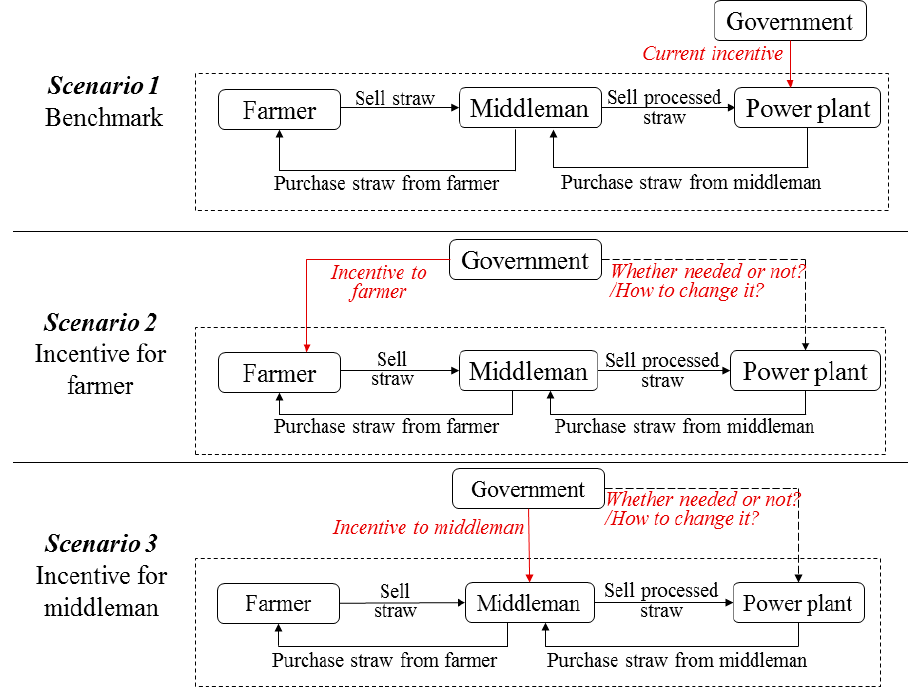
Figure 1. Biomass supply chain under different incentive scenarios.